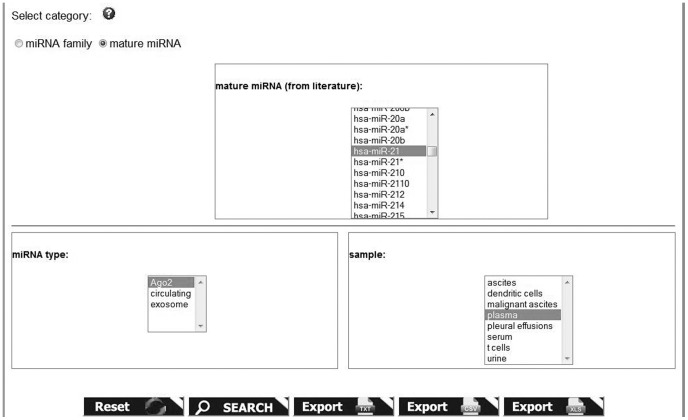
Advanced search.